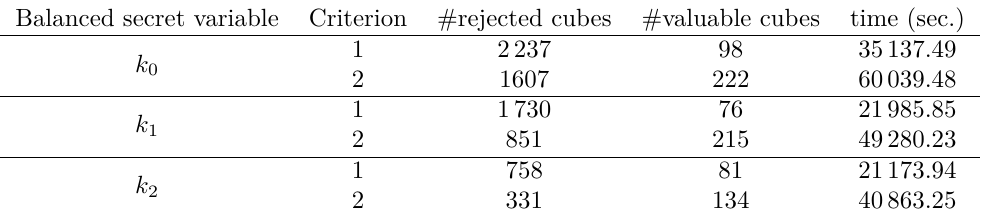
Table 4: Comparisons between secret variables and criteria for 840-round Trivium . Balanced secret